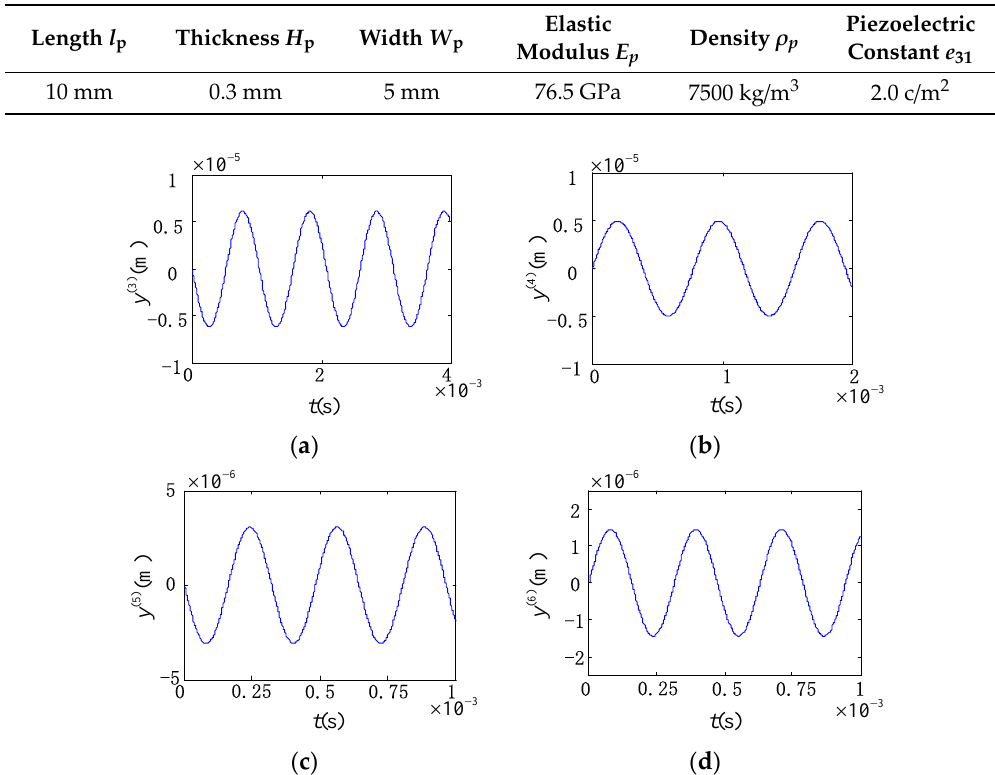
Table 2. Parameters of the piezoelectric sheets.